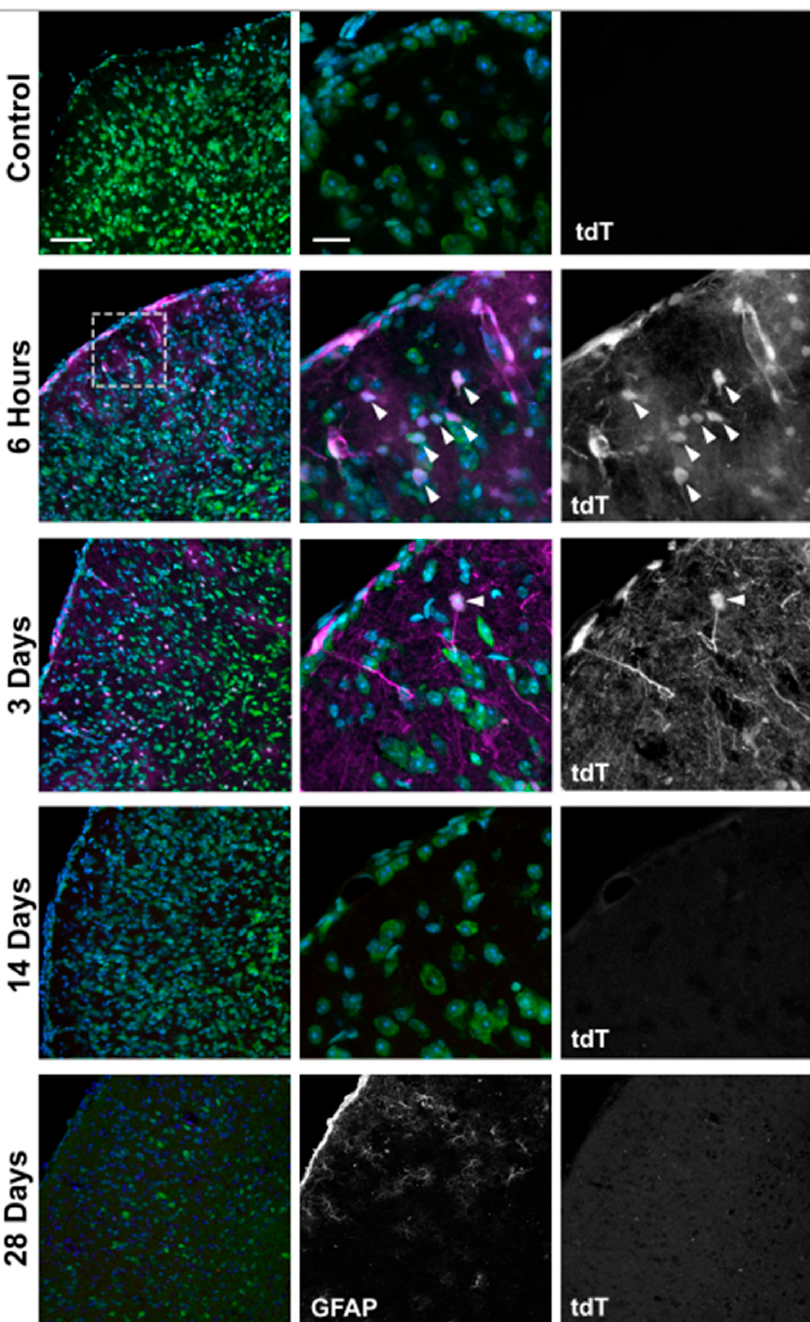
Figure 9. A timecourse of superior colliculus sections after OHT. Superior colliculus was stained using NeuroTrace (green) and DAPI (blue); tdTomato (tdT, magenta) reporter indicates cells subjected to hypoxia. Left panels were imaged at 20 × magnification (scale bar = 50 µ m) and center panels at 60 × magnification (scale bar = 20 µ m). Right panels are the tdTomato fluorescence alone, in grayscale. In the control superior colliculus, no tdTomato label (right panel) was observed. tdTomato labeling was most widespread at 6 h and 3 d after OHT, including colocalization with NeuroTrace-positive cells (arrowheads). The dotted line in the 6 h panel is the outline of the 60 × center panel. By 14 d, tdTomato labeling was no longer evident in the colliculus. In the 28 d panels, all are at 20 × magnification, with the center showing GFAP labeling and the right the tdT. Five brains per group and ten sections per brain were analyzed from the 4 time points (6 h, 3 d, 14 d, 28 d).